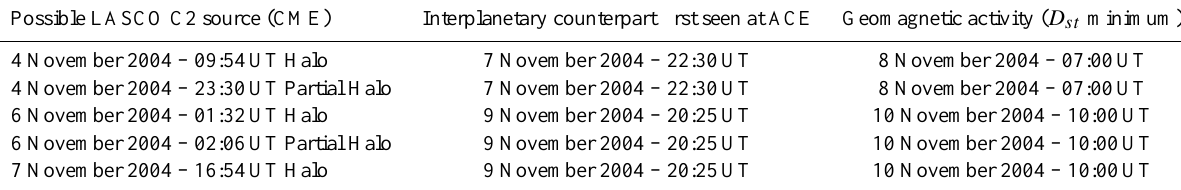
Table 1. A summary of the events investigated here in chronological order of their possible source(s) as seen by the SOHO | LASCO C2 instrument. Table taken from Bisi et al. (2008a) and information partially taken from Zhang et al. (2007a) and also from Harra et al. (2007). Possible LASCO C2 source (CME) Interplanetary counterpart first seen at